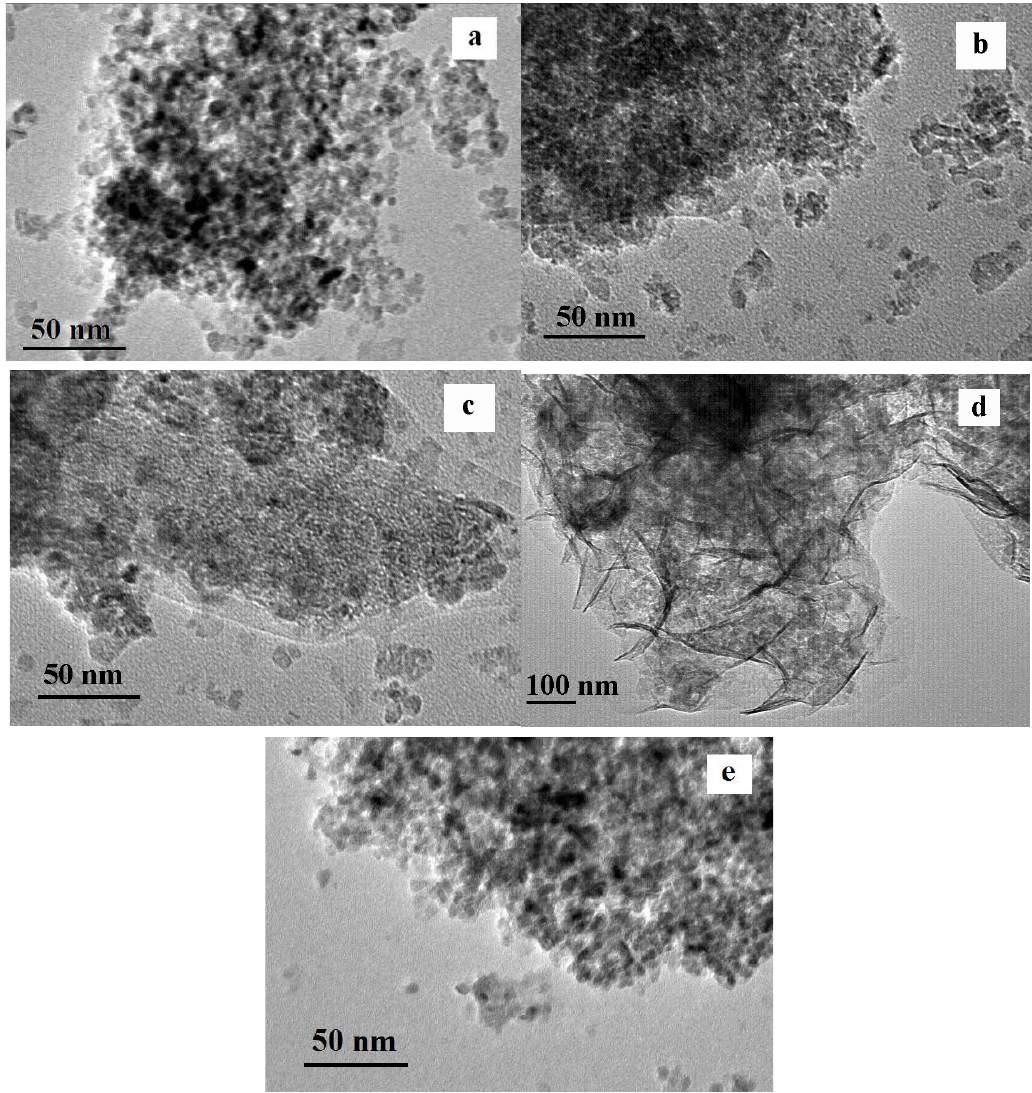
Figure 3. TEM of catalysts. ( a ) Cat-fresh, ( b ) Cat-used-150, ( c ) Cat-used-300, ( d ) Cat-used-450 and ( e ) Cat-refreshed.